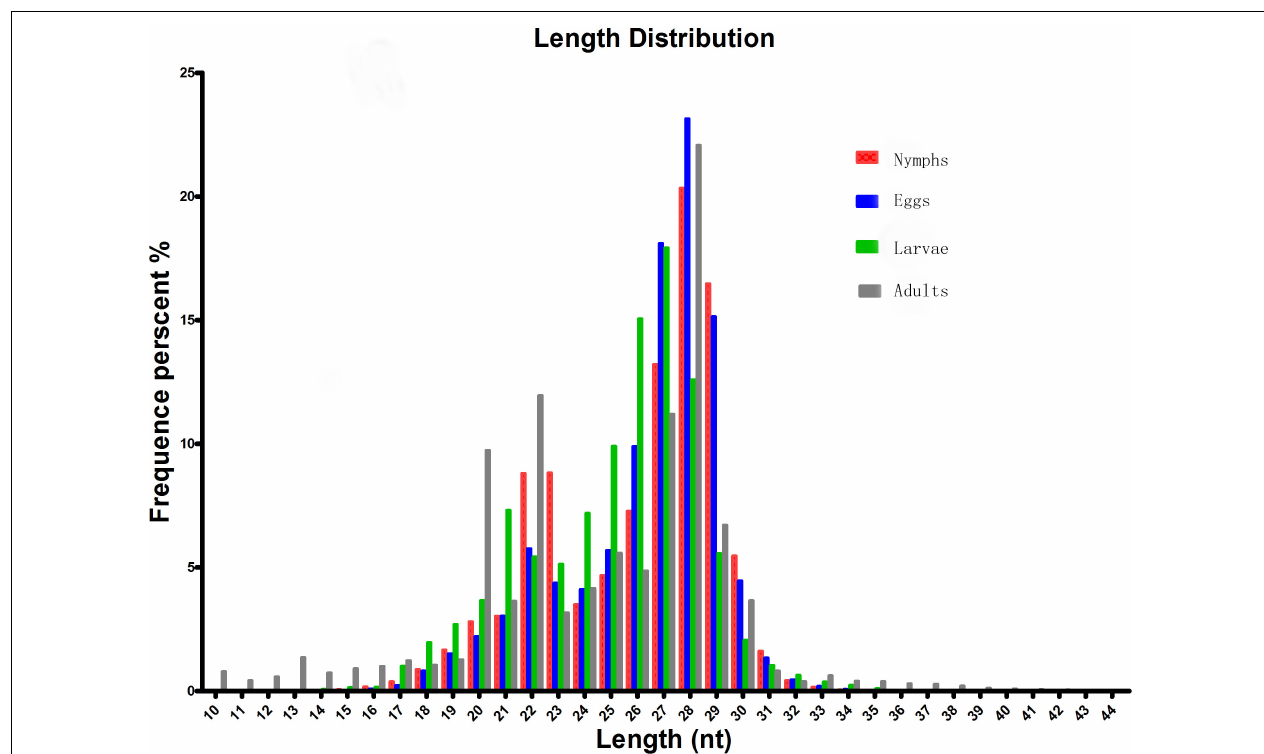
FIGURE 1 | Length distribution and abundance of sequences in different developmental stages of Hyalomma anatolicum anatolicum . Contaminant reads from the fastq file were removed to obtain clean reads. Then, the length distribution of these clean reads was summarized. Normally, the length of small RNA is between 18 and 30 nt. The length distribution analysis is helpful to assess the compositions of small RNA samples. For example, miRNA is normally 21 or 22 nt, siRNA is 24 nt, and piRNA is 30 nt.